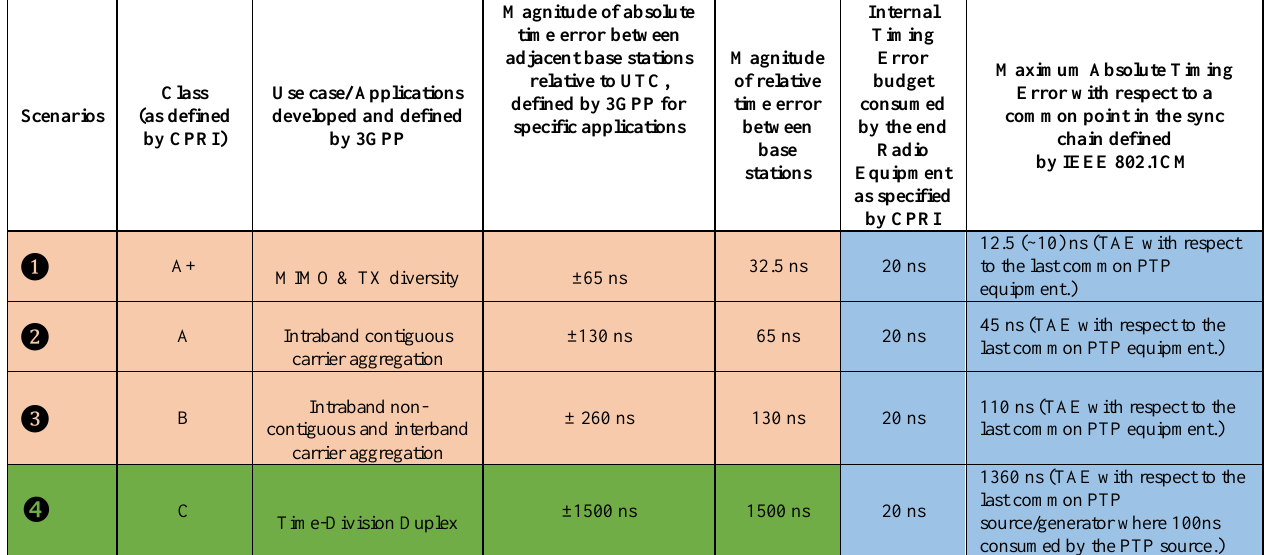
Table 1. Illustration of Phase/Time Synchronization Timing Error Magnitude for the